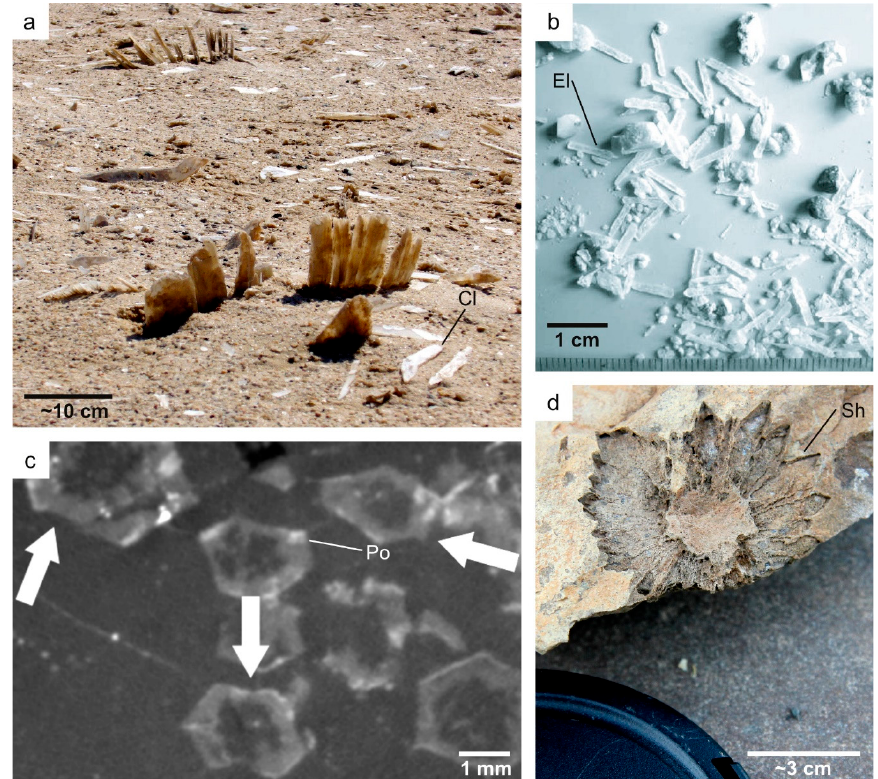
Figure 4. Crystals and crystal pseudomorphs. ( a ) Exhumed large gypsum crystals from sabkha deposits. Crystals shows an elongate shape and the tendency to split along definite planes of weakness (cleavage: Cl). Gypsum crystals formed earlier than those developing today. Sabkha of Barr Al Hikman, Sultanate of Oman. Larger crystals are 12 cm long. Image from [35]. ( b ) Nest of fibrous gypsum crystals 10–20 cm below the sabkha surface. Gypsum crystals show an elongate shape (El). Sabkha of Barr Al Hikman, Sultanate of Oman. Image from [35]. ( c ) Computed tomography scan (CT-scan) of crystal pseudomorphs. Crystals show a polygonal cross-section (Po). Large arrows show pointed spurs close to some vertices, which are a typical feature of aragonite contact twins. 3.48 Ga-old Dresser Formation (Pilbara Craton, Australia). Image from [36]. ( d ) Glendonite moulds from the shallow marine Rurikfjellet Formation [37] showing sharp contact with the host rock (Sh). Early Cretaceous of